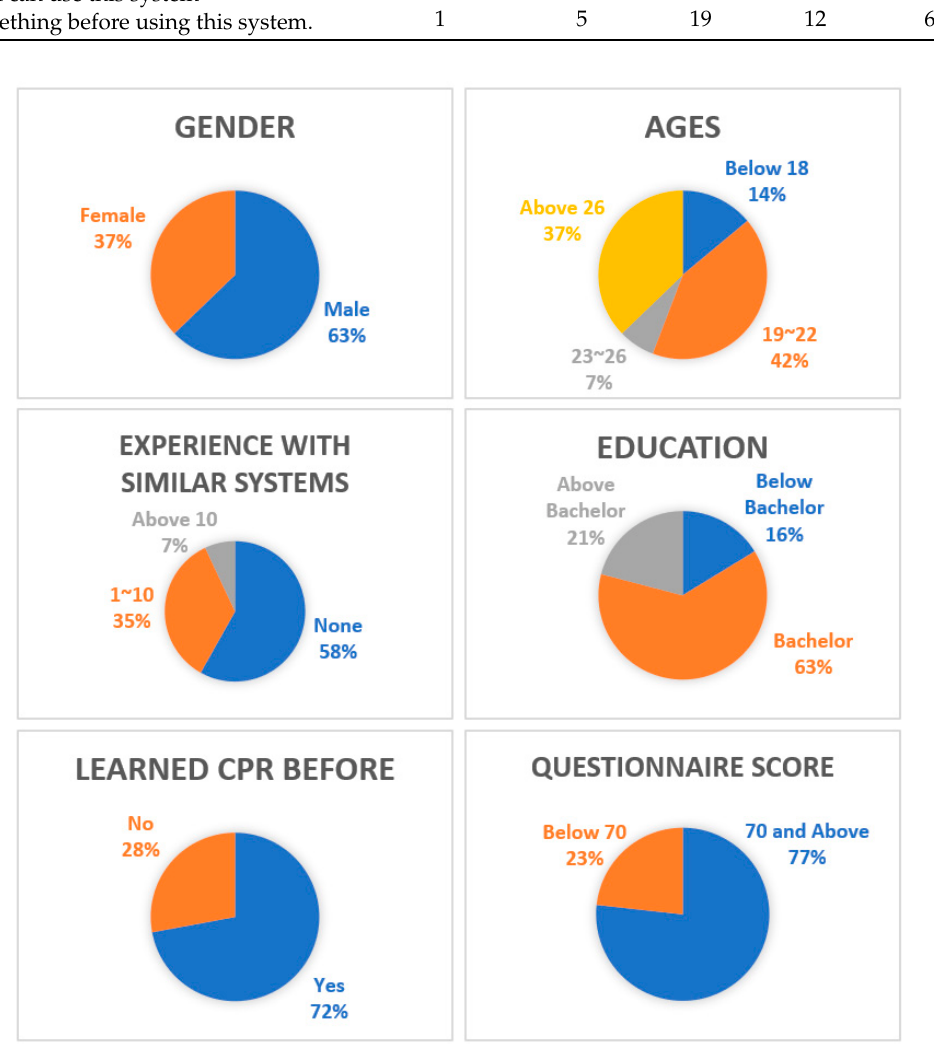
Figure 22. The analysis results of the questionnaire.